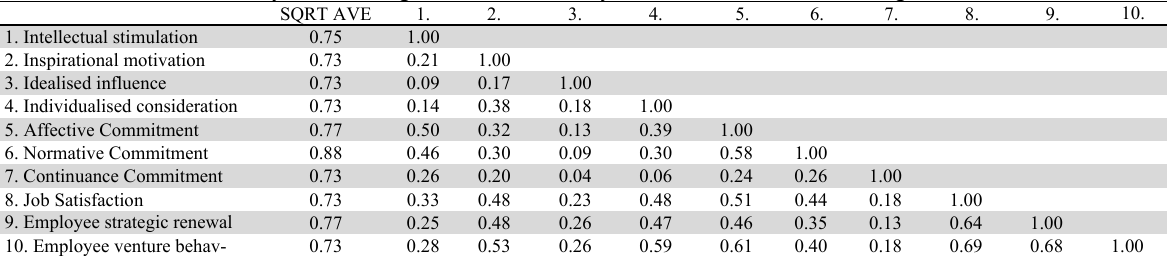
Fornell-Larcker criterion analysis for testing discriminant validity and correlations matrix among